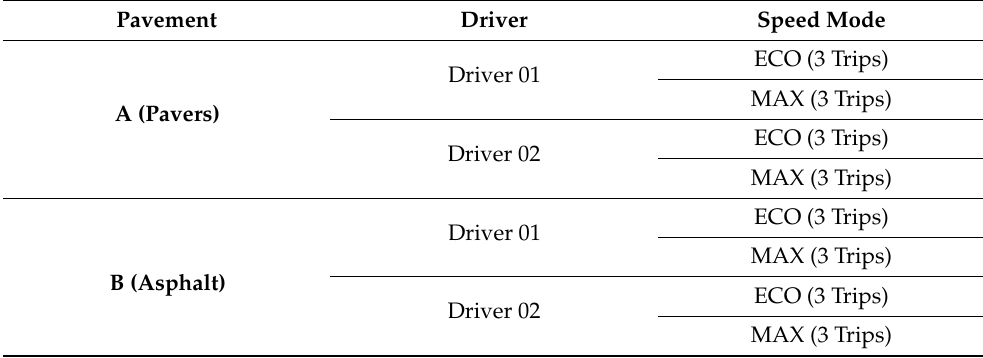
Table 4. Design of the